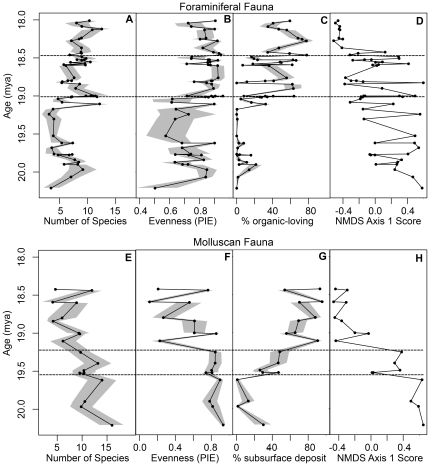
Changes in community structure over time.(A) Foraminiferal species richness, (B) foraminiferal community evenness, (C) the proportion of organic-loving foraminifers, (D) NMDS axis 1 ordination scores from foraminiferal species abundances, (E) molluscan species richness, (F) molluscan community evenness, (G) the proportion of subsurface deposit-feeding bivalves, and (H) NMDS axis 1 ordination scores from molluscan species abundances. Gray shading indicates the 95% confidence intervals of the ecological metrics following sample size standardization. Dashed lines indicate the boundaries between communities (Table 2).